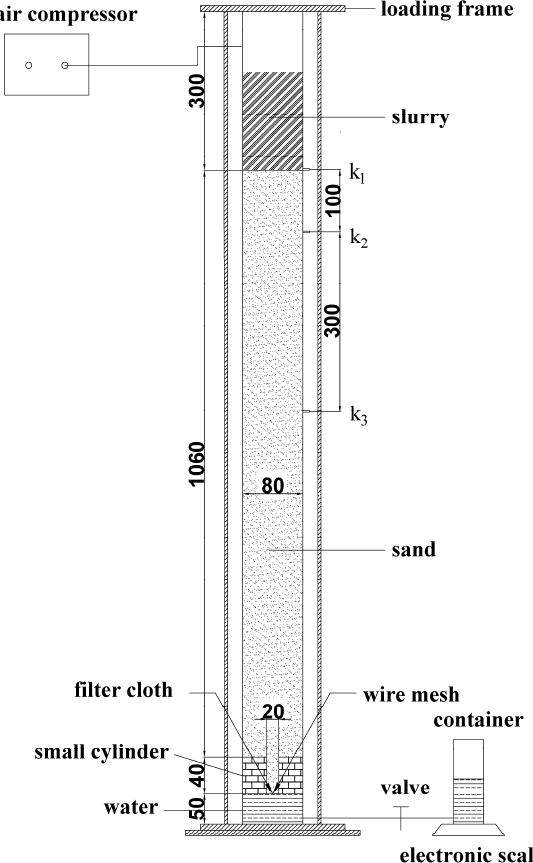
Figure 3. Device for of pressure infiltration of bentonite slurry.